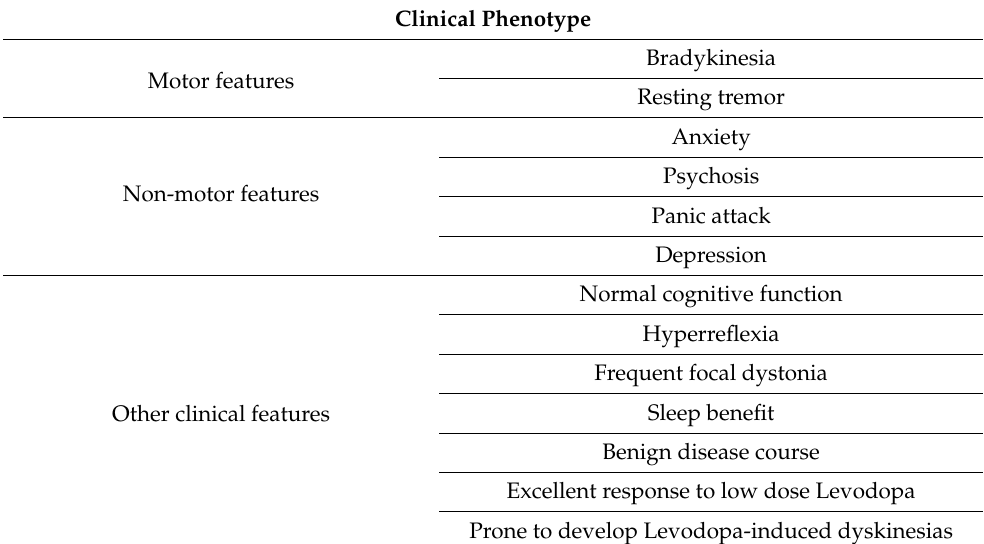
Table 1. Clinical phenotypes frequently reported in PD cases with PARK2 mutations